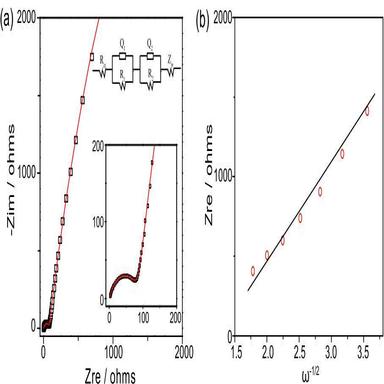
(a) The EIS Nyquist plots and the corresponding equivalent circuit used to fitting the plots. b) The variations and fittings between Zre and the reciprocal square root of the angular frequency in the low-frequency region of the LMB/BxOy@C.